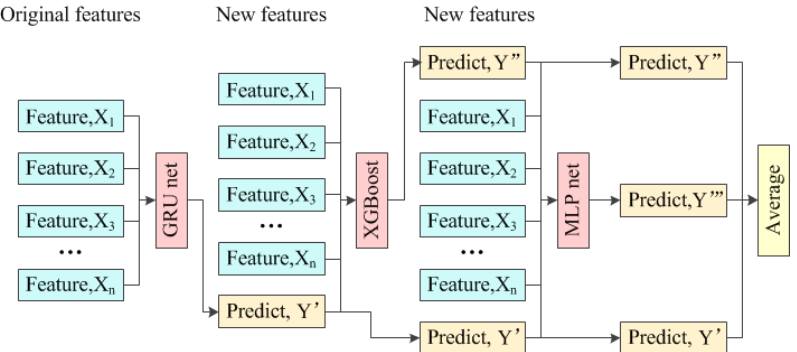
Figure 1. The principle of the model ensemble.